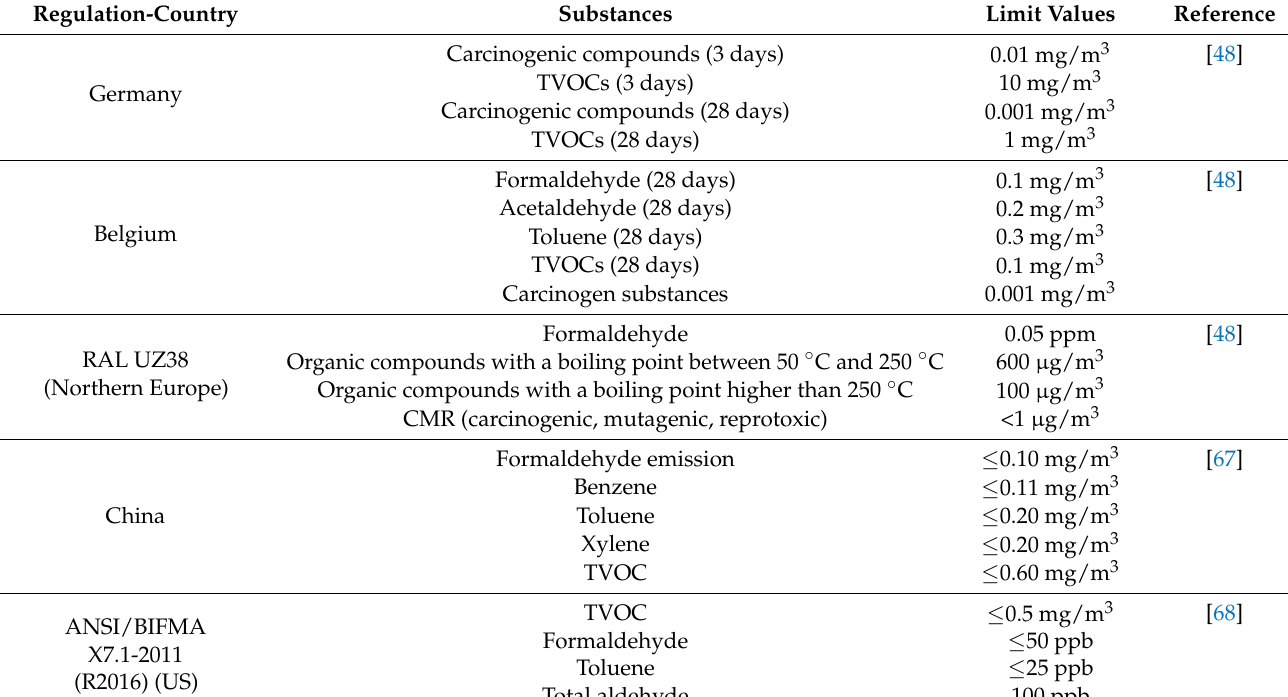
Table 3. Different regulations in various